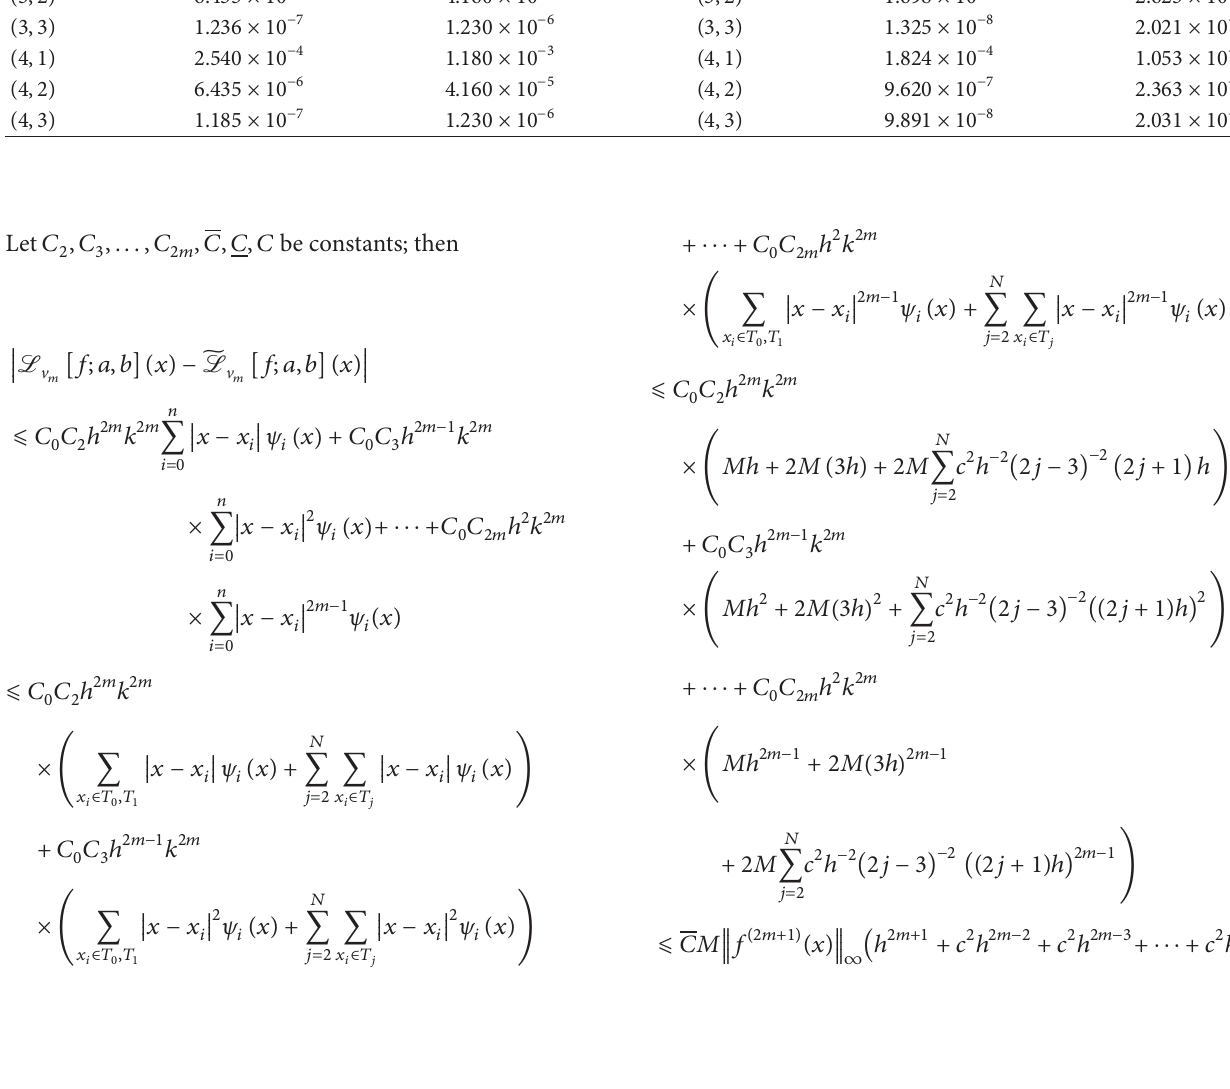
Table 1: Numerical results of the operators 𝑆 𝐵